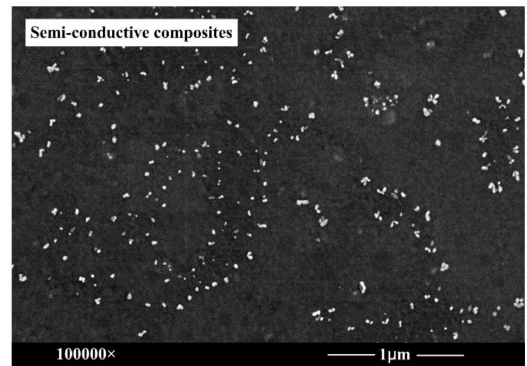
Figure 2. Scanning electron microscopy (SEM) image of semi-conductive composites.